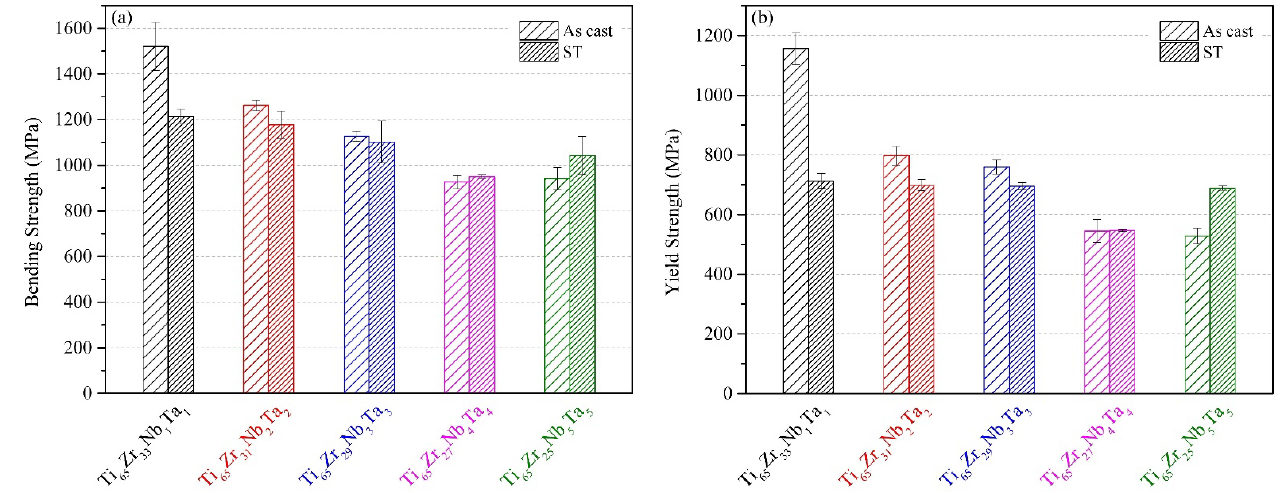
Figure 7. Strengths of the Ti–Zr–Nb–Ta MEAs obtained through three-point bending tests: ( a ) bending strength and ( b ) yield strength.